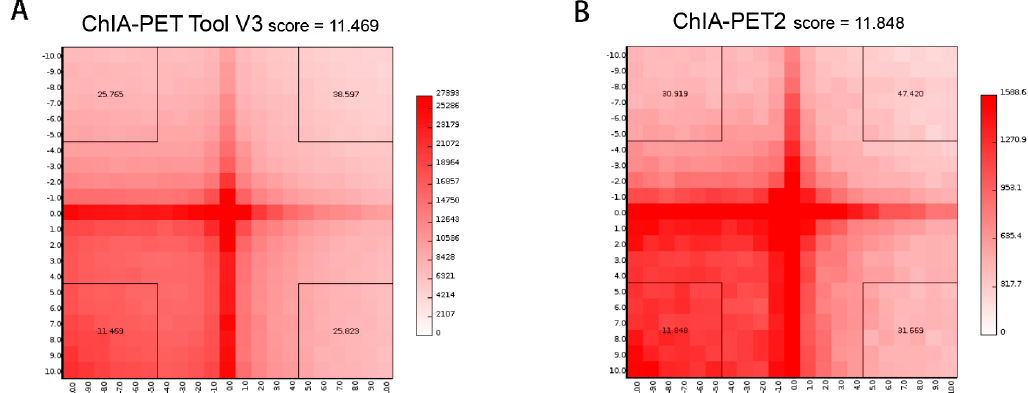
Figure 20. Aggregate peak analysis (APA) plots of significant interactions detected by different tools from human GM12878 cells. ( A ) APA plot of significant interactions detected by ChIA-PET Tool V3. ( B ) APA plot of significant interactions detected by ChIA-PET2. Significant interactions require at least three supportive PETs and FDR of less than 0.05. Interaction matrices are built with BEDPE files from ChIA-PET data after removing duplicates. Interaction counts are summed for all pairs of loci in 25 kb bins.